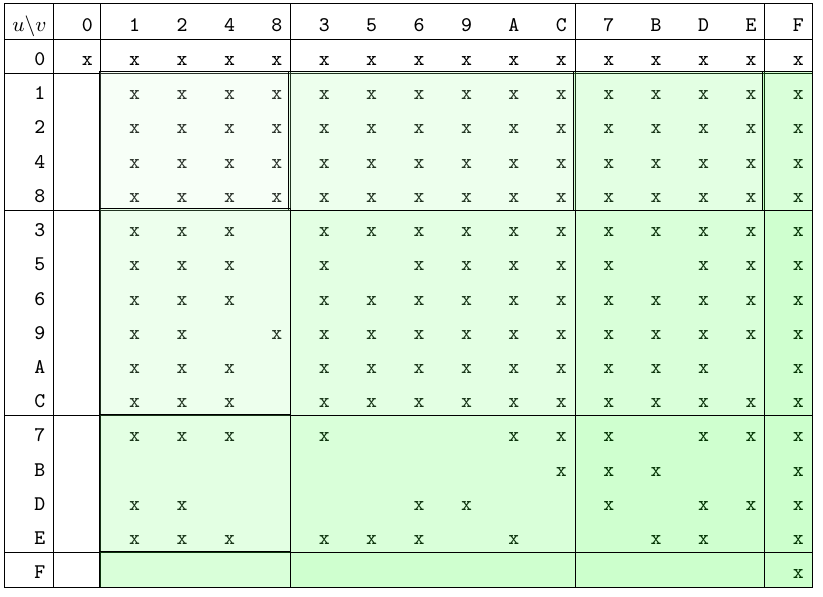
of the Serpent S-boxes S 0 2